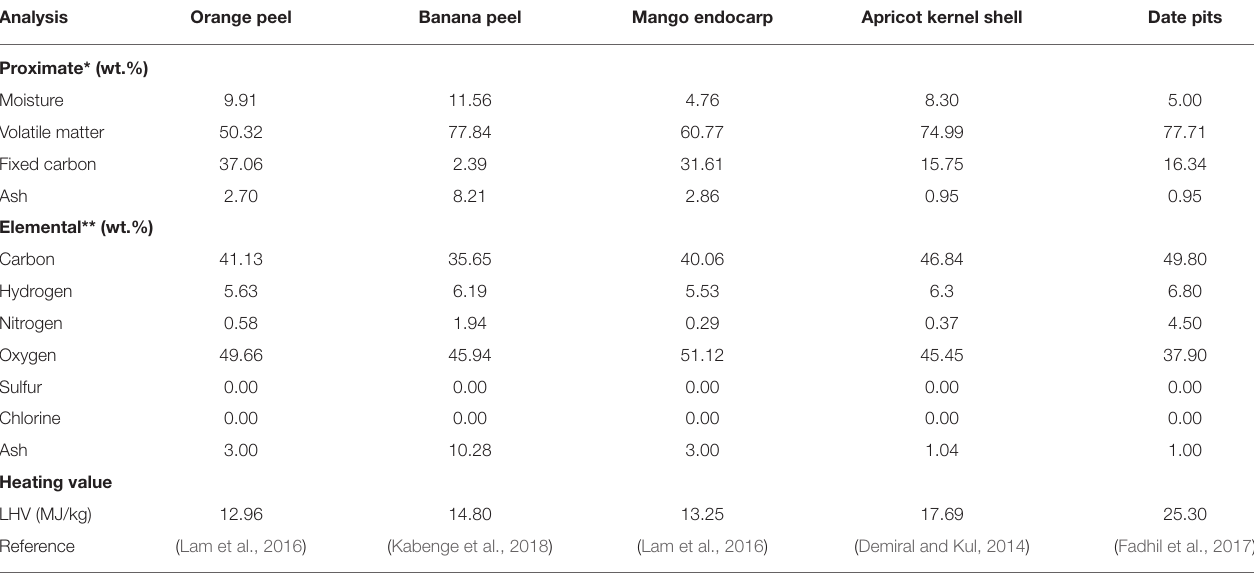
TABLE 1 | Proximate and elemental analyses of the selected fruit wastes. Analysis Orange peel Banana peel Proximate* (wt.%)